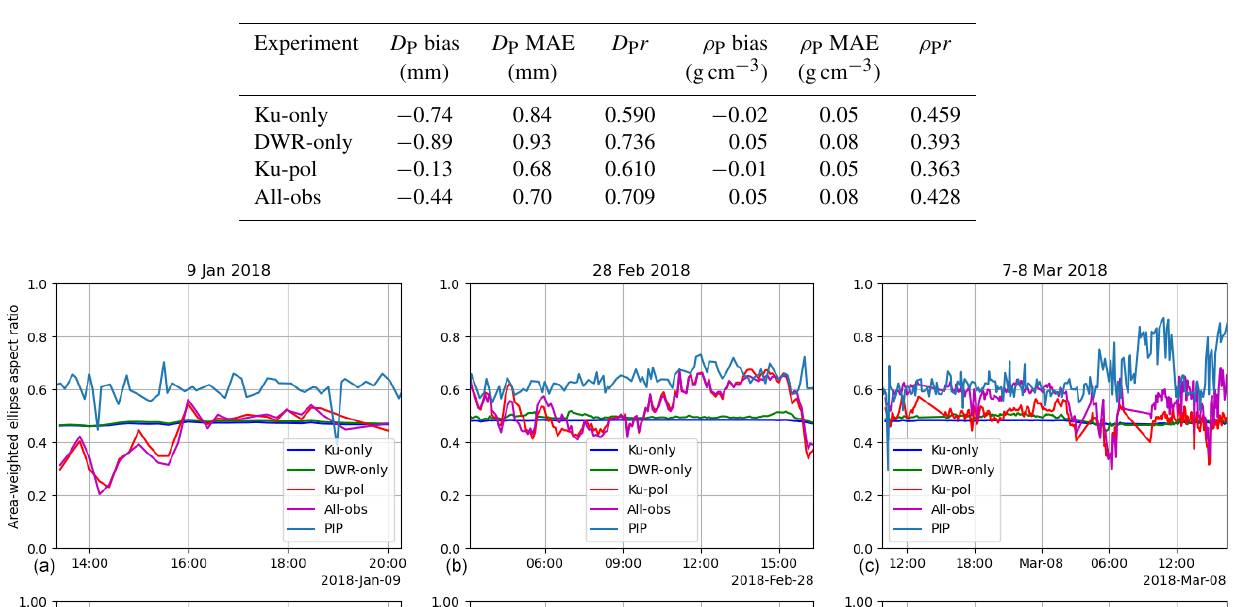
Table 8. Mean bias, absolute error (MAE), and correlation coefficient ( r ) of PIP-derived versus D3R-estimated mean volume-weighted particle diameter ( D v P ) and PIP effective density ( ρ P = S/S V ) for each of the four retrieval experiments.